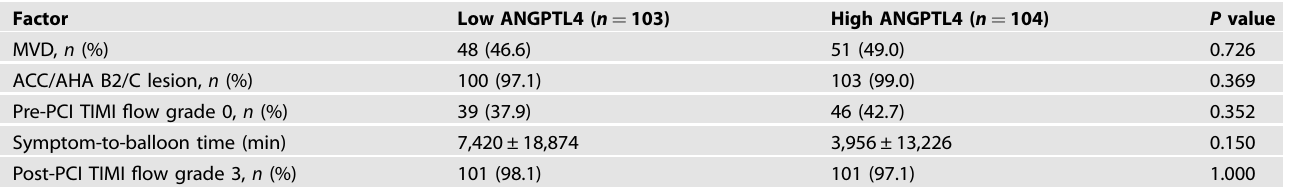
Table 2. Coronary angiographic and procedural characteristics of patients with ANGPTL4 levels above or below the median. Factor Low ANGPTL4 ( n =